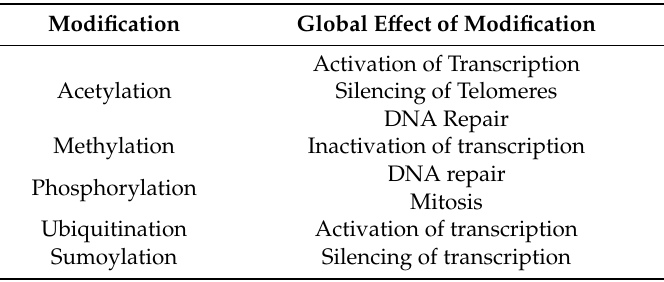
Table 2. E ff ects of histone